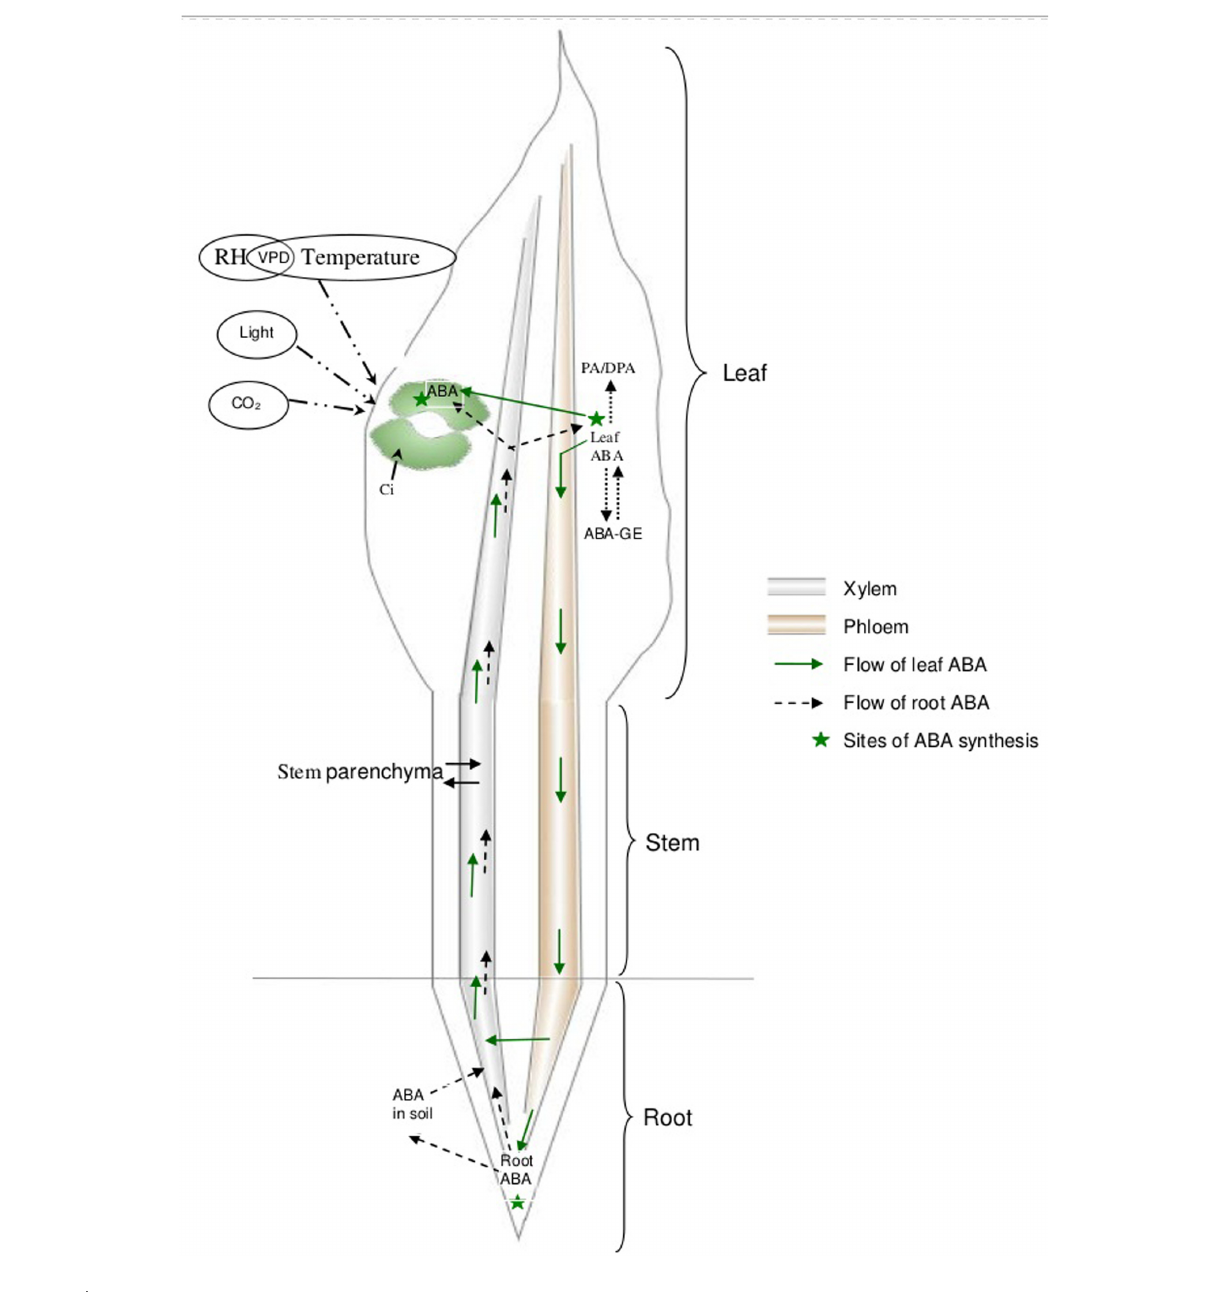
FIGURE 1 | Schematic representation of the kinetics of ABA through the